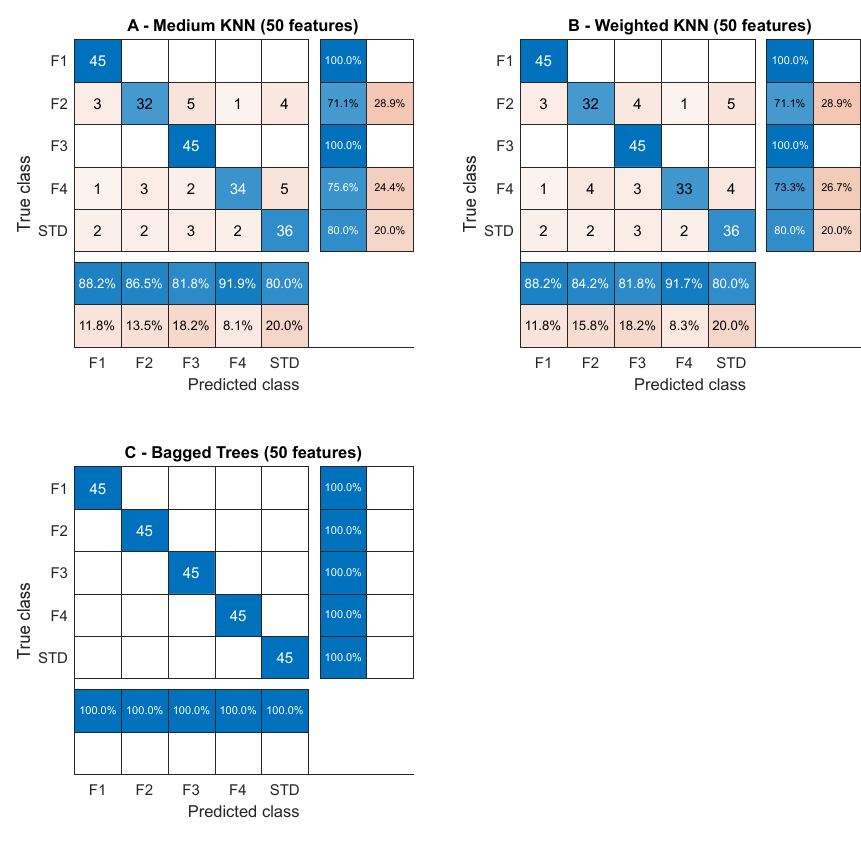
Figure 13. Confusion matrices.